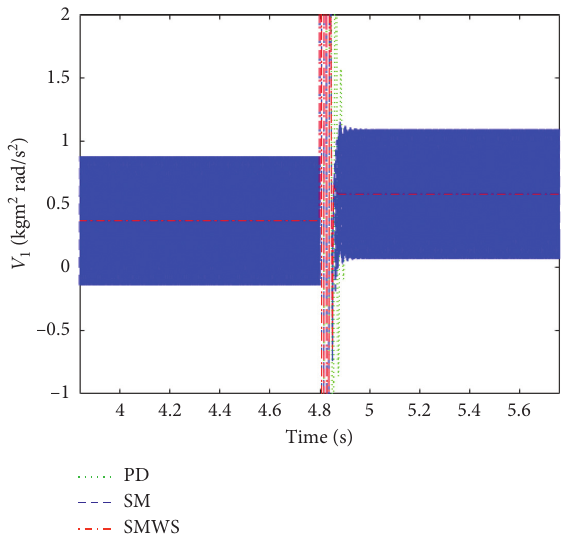
Figure 5: A zoom in the fictitious input of the first electricity